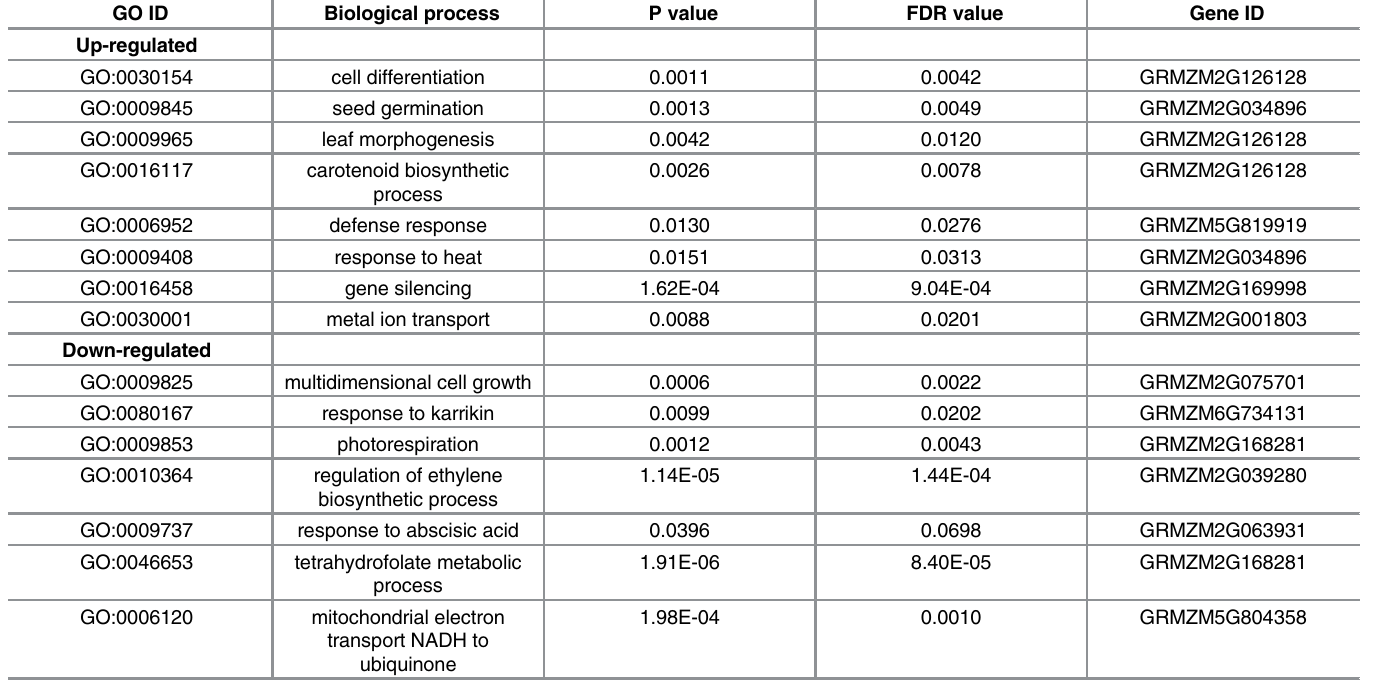
Table 1. GO enrichment analysis of specific maternal expression-level dominance genes of Zheng58. GO